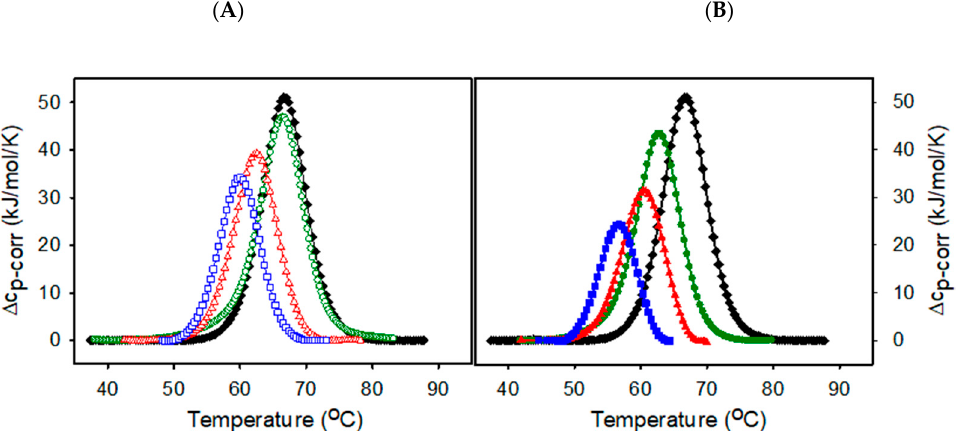
Figure 2. DSC thermograms of lysozyme at the absence (black) and at the presence of ( A ) EMIM-ac (0.5%—green open circles; 1%—red open triangles; 5%—blue open squares. ( B ) EMIM-BF 4 : 0.5%— green circles; 1%—red triangles; 5%—blue squares. Lysozyme concentration 2mg/mL, heating rate 1.5 °C/min.